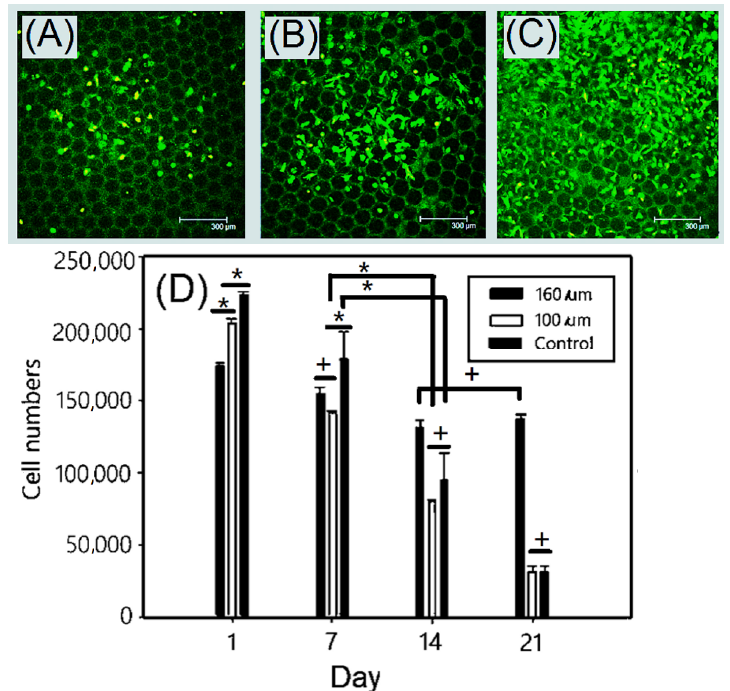
Figure 6. Live/dead cytotoxicity viability assay of chondrocytes on the gelatin-based hydrogel scaf- fold after ( A ) 1, ( B ) 4, and ( C ) 7 days (Scale bar = 300 µ m) and ( D ) MTT assay results of chondrocytes on the gelatin-based hydrogel scaffold. Green: live cells, red: dead cells, orange or yellow: overlap of live and dead cells. Values with different superscripts were significantly different ( p < 0.05); *, statistical significance between the groups ( p < 0.05); +, nonsignificance within the group ( p > 0.05). Since chondrocytes normally secrete extracellular matrix, total collagen/DNA and the amount of GAG/DNA were the basis for judging the degree of cartilage of cells. As shown in Figure 7, the amount of total collagen/DNA of static culturing chondrocytes on gelatin- based hydrogel scaffolds increased with the increase of culture time, from about 5.0 ( µ g/ µ g) for 1 day to ca. 17.0 ( µ g/ µ g) for 21